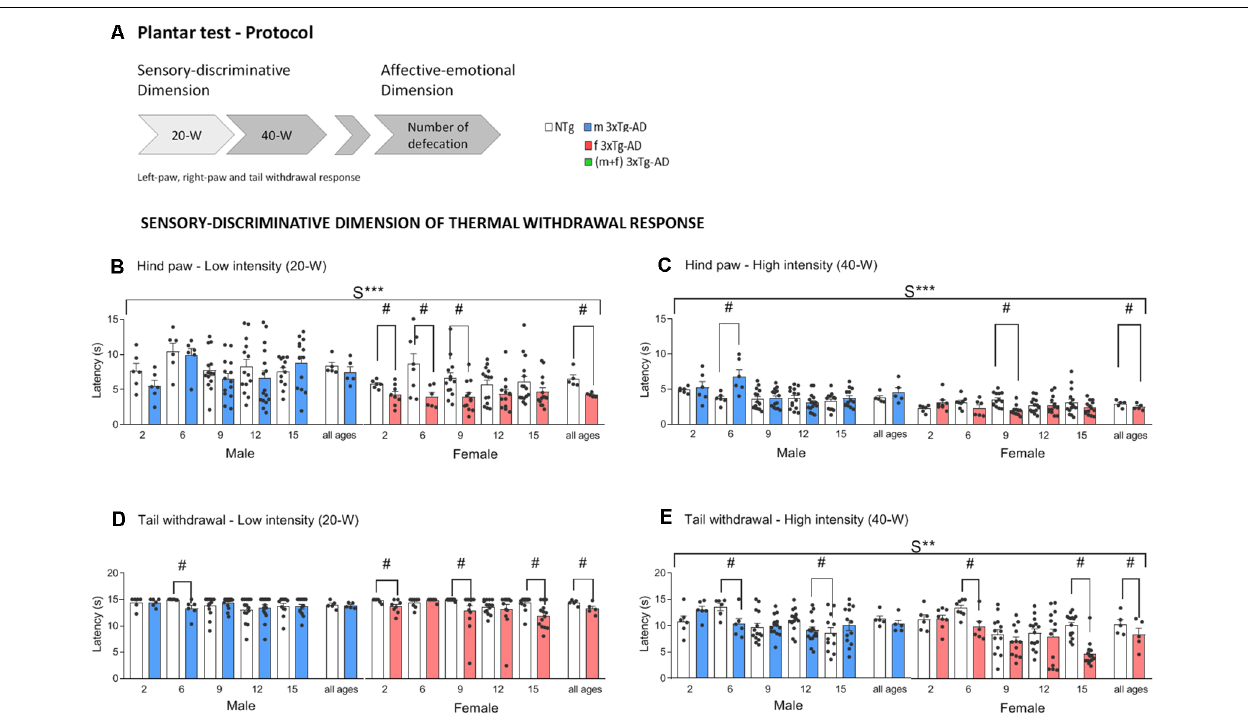
FIGURE 1 | Schematic representation of the plantar test of thermal stimuli protocol used. Sensory-discriminative dimension of thermal withdrawal response in male and female 3xTg-AD and age-matched NTg mice with normal aging. (A) At low-20W and high-40W active intensity, infrared light stimuli were applied underneath the plantar surface of the mice’s hind paws (both right and left) and tail every 10 min. Paw (PWL) and tail (TWL) withdrawal latency were recorded for a sensory-discriminative dimension and the total number of defecations for an affective-emotional dimension. (B) Hind paw withdrawal responses at low-intensity 20-W (C) and high-intensity 40-W (D) . Tail withdrawal at low-intensity 20-W (E) and high-intensity 40-W. Groups: NTg, non-transgenic mice (open bar); 3xTg-AD, transgenic mice (male “black,” female “red” bar). Error bars represent mean ± SEM. Statistics: Sex effect, S***, p < 0.001 or S** p < 0.01. Student t- test comparisons are shown in the graphs as # p < 0.05 vs. the